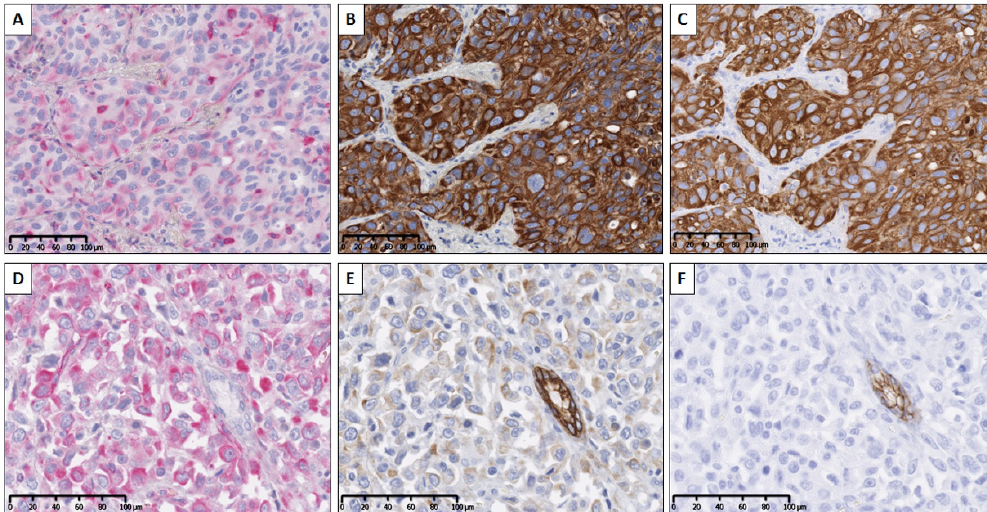
Figure 4. SCIM ( a – c ) and hybrid E/M status ( d – f ) validation. ( a ) VIM expression evidenced in